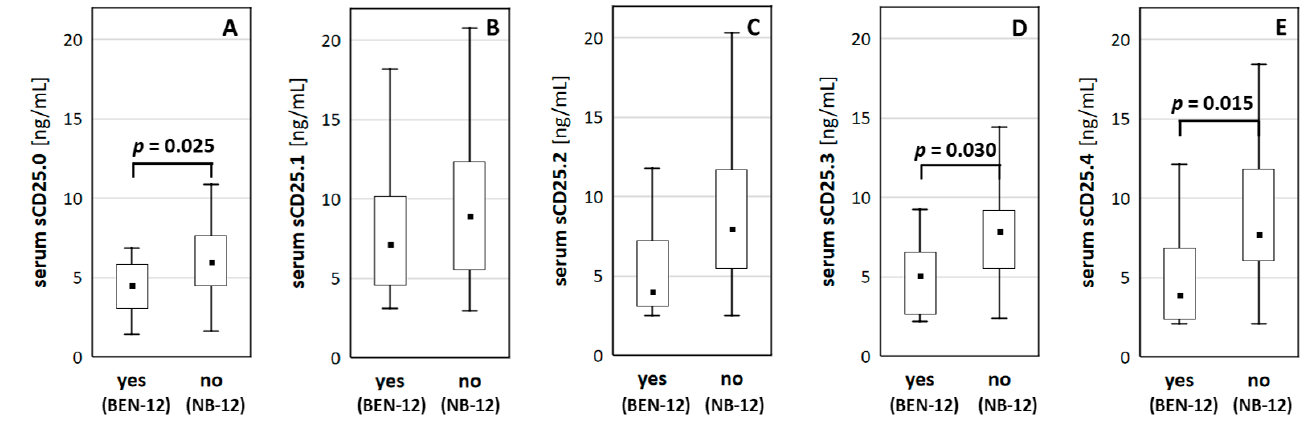
Figure 2. Serum sCD25 levels stratified by achieving long-term benefits from treatment. Figure presents medians (filled squares), interquartile ranges (boxes), and ranges excluding outliers for sCD25 protein measured at ( A ) baseline and at the end of ( B ) cycle 1, ( C ) cycle 2, ( D ) cycle 3, and ( E ) cycle 4 in patients who obtained (BEN-12) and lacked (NB-12) clinical benefits after 12 months from the start of